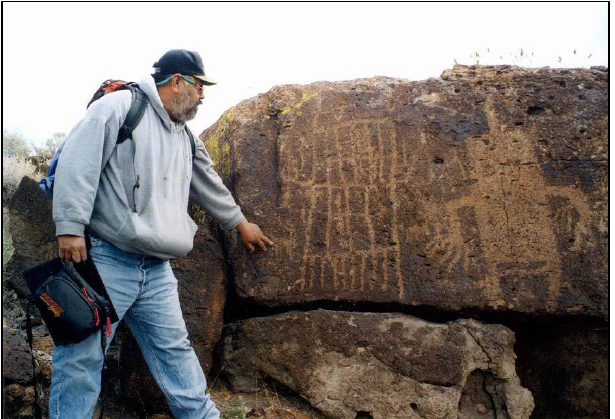
Figure 8. Co-researcher and Western Shoshone Elder from CGTO Writers Committee pointing to a mountain sheep pecking while explaining transformed shaman and a water baby to the right (Source: Stoffle).